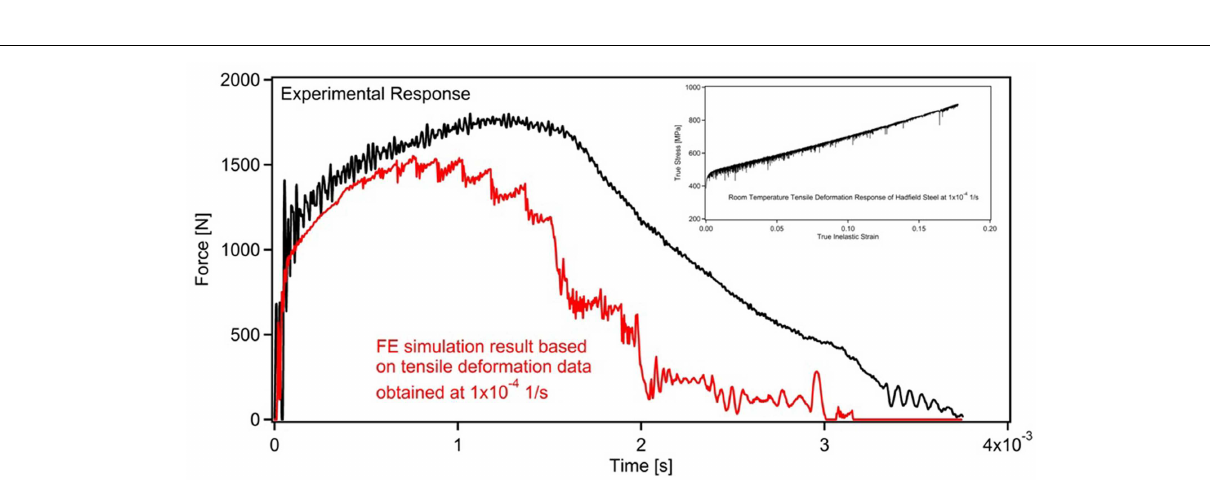
accuracy and computational efficiency of the simulations.